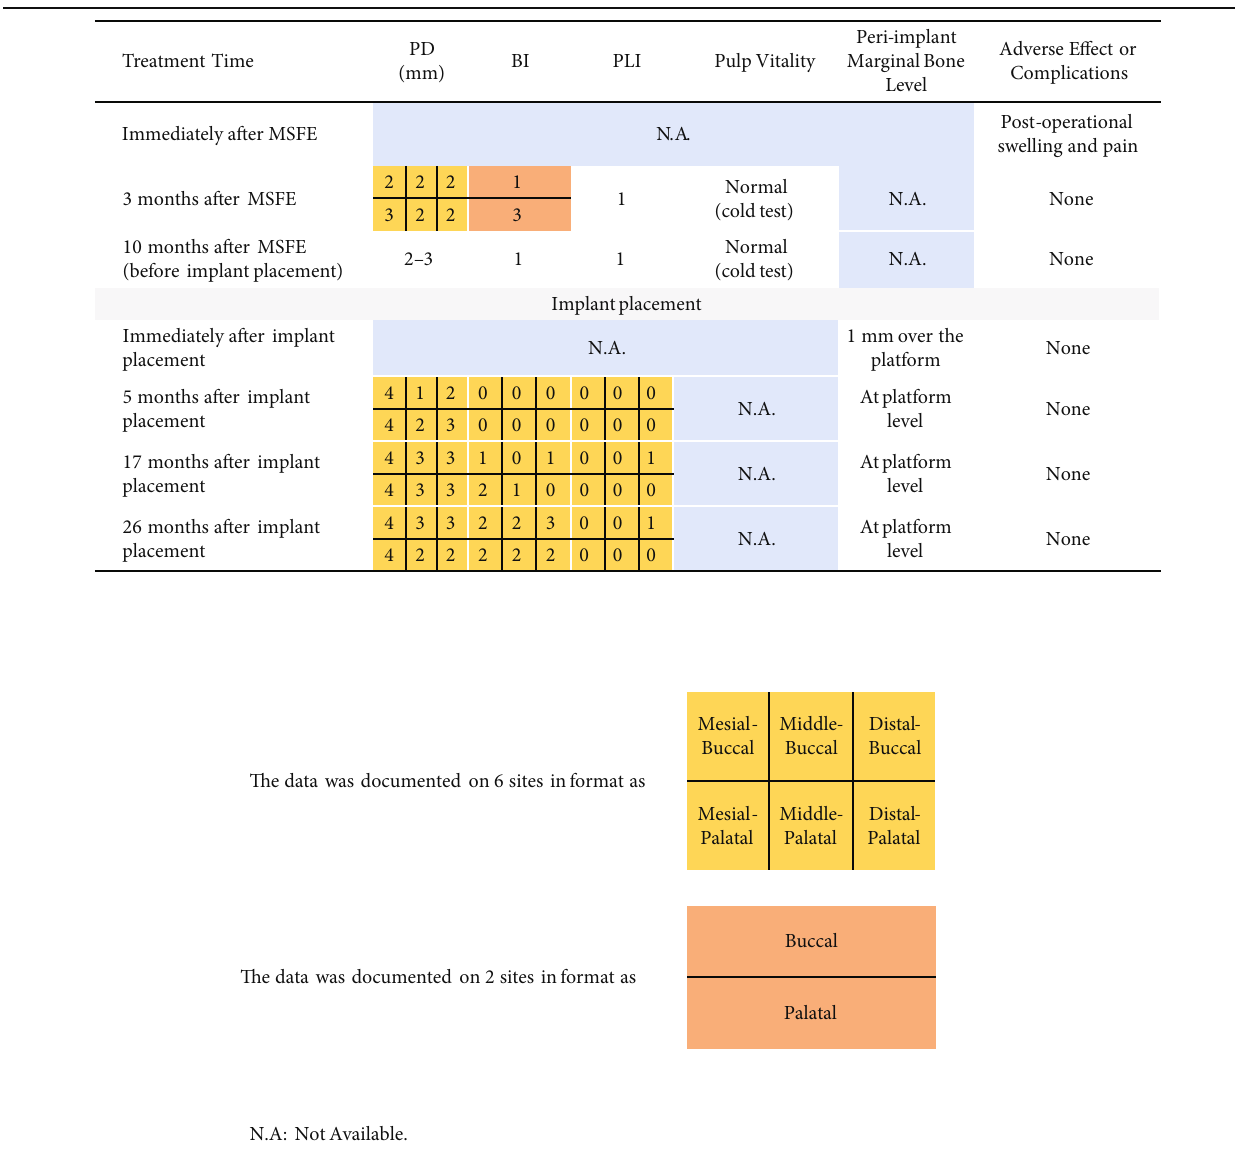
Table 1: Clinical evaluation of tooth #16 at each follow-up